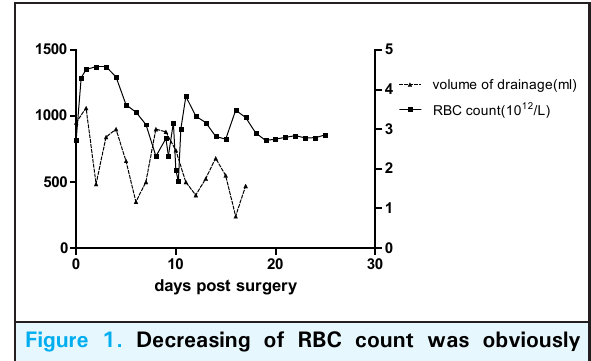
Figure 1. Decreasing of RBC count was obviously corelated with the volume of drainage due to protracted bleeding.